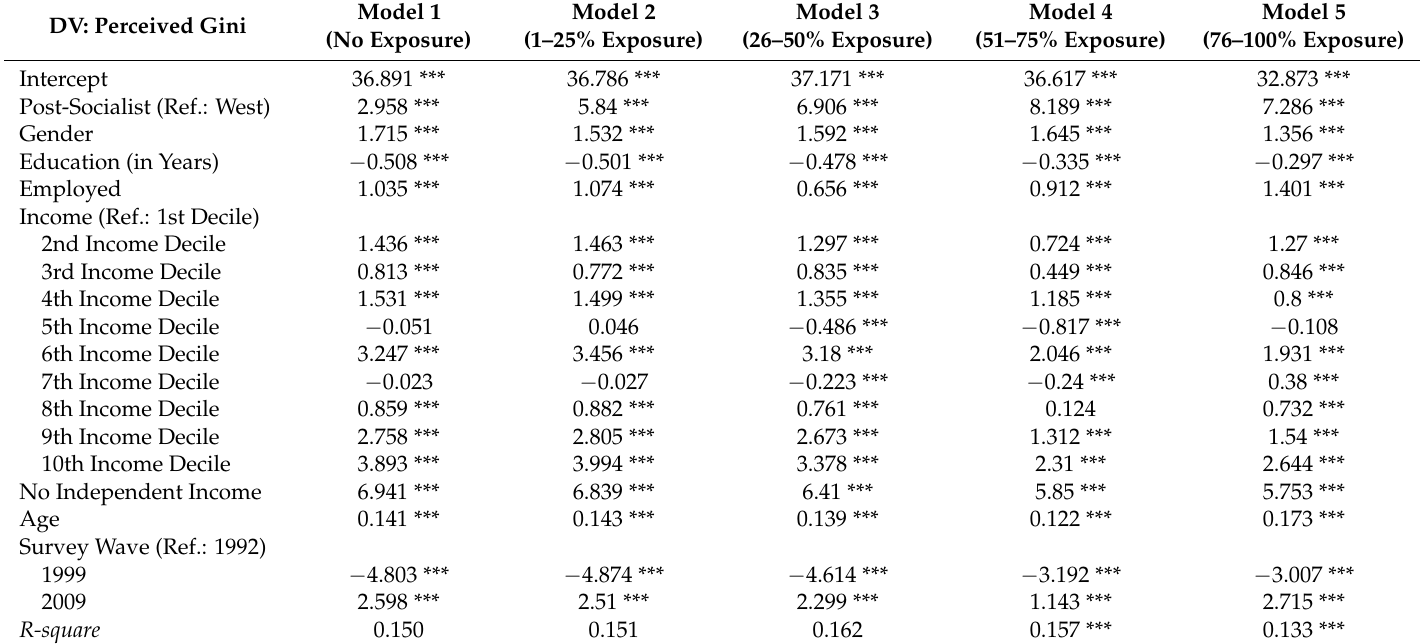
Table A11. Bootstrapped OLS regression models to explain the perceived Gini by exposure rate (corresponding with Figure 6b). Model 1 Model DV: Perceived Gini (No Exposure)